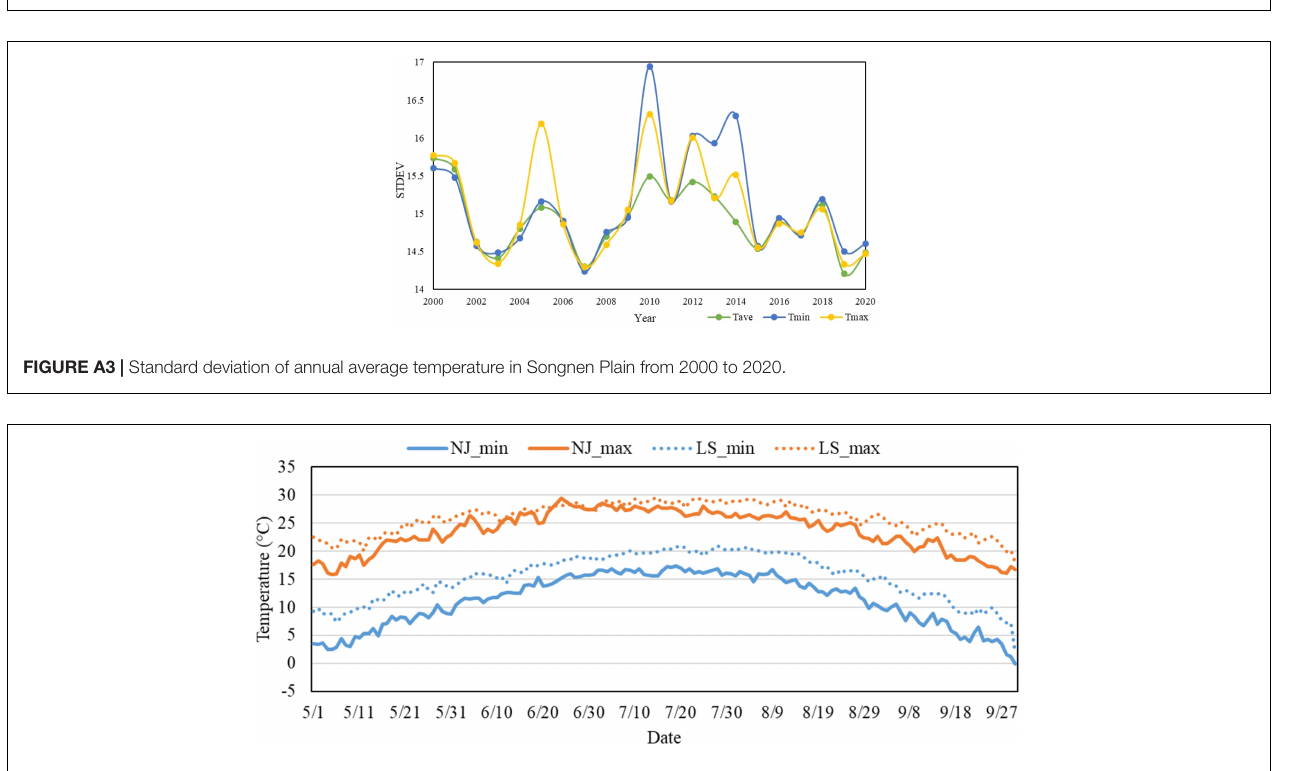
Frontiers in Plant Science |